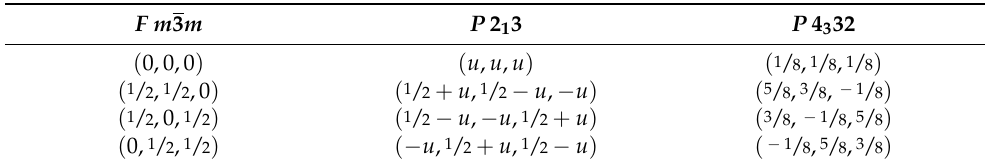
Table 6. Atom positions in cubic, achiral and chiral structures related to space group P 2 1 3. Tabulated are the positions for u ≤ 1/8. Others may be found using a shift vector ( n / 4 , n / 4 , n / 4 ) ( n = 1,2, 3) and the equivalence of positions with − u and 1 − u . The minimum distance of the positions between √ P 2 1 3 and F m 3 m is in all four cases u